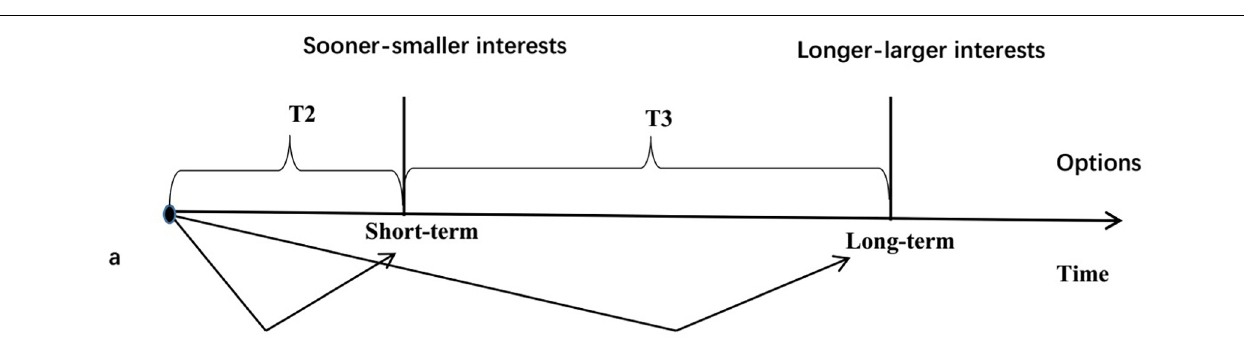
FIGURE 1 | Intertemporal decision making in the case of choice deferral behavior.